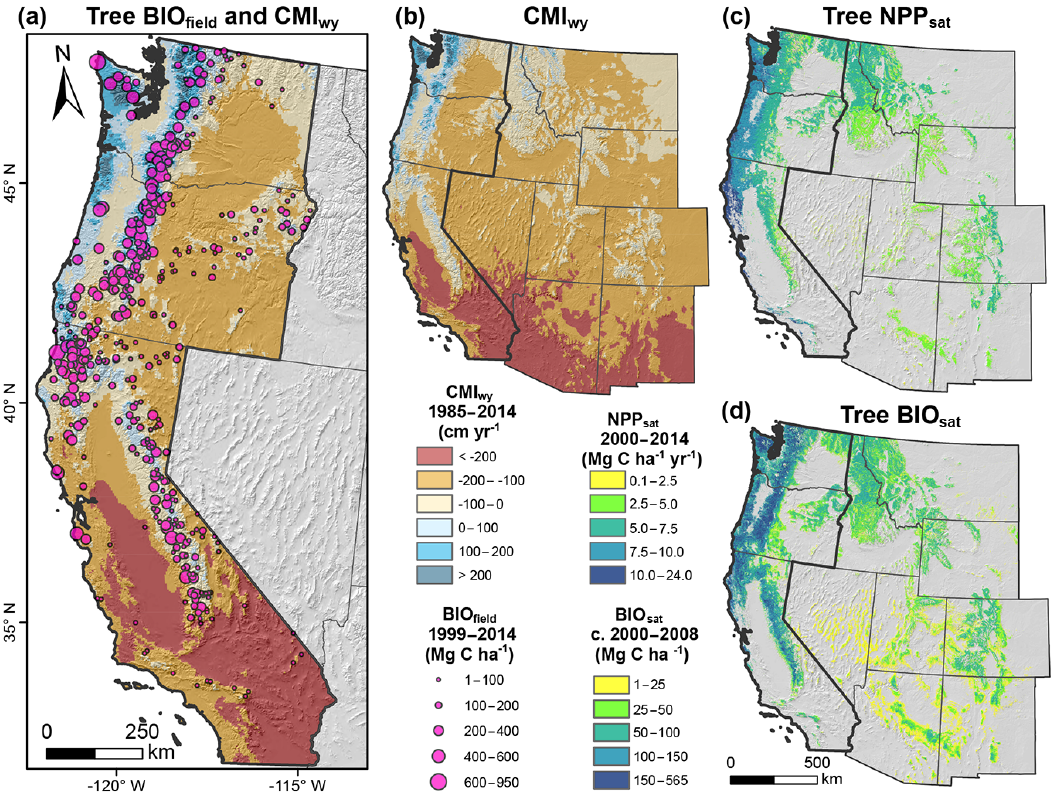
Figure 1. Mean climatic moisture index (CMI wy , cmyr − 1 ) , tree net primary productivity (NPP, MgCha − 1 yr − 1 ) , and live-tree biomass (BIO, MgCha − 1 ) in the western US. (a) Tree BIO derived from field measurements (BIO field ) at mature sites (>100 years) in WAORCA. For visual clarity only 20% of the 1953 sites are depicted. (b) The CMI wy was computed as monthly precipitation minus reference evap- otranspiration summed over the annual water year (October–September) and then averaged from 1985 to 2014. (c) Mean annual NPP was quantified using MODIS satellite data from 2000 to 2014 (NPP sat ) . (d) Tree BIO was quantified using satellite-derived estimates of carbon stocks (BIO sat ) . Table 1. Summary of tree net primary productivity (NPP,MgCha − 1 yr − 1 ) , live biomass (BIO,MgCha − 1 ) , and carbon residence time (CRT, year) for stands over 100 years old across both WAORCA and the broader western US. These forest characteristics were quantified for WAORCA using field measurements from 1953 sites and for the western US using satellite-derived data sets covering 18Mha of mature forest. Satellite data sets included MODIS NPP and an estimate of BIO derived by combining existing maps of aboveground biomass with additional estimates of carbon storage in coarse roots, fine roots, and foliage. These carbon stocks and fluxes combine above and belowground